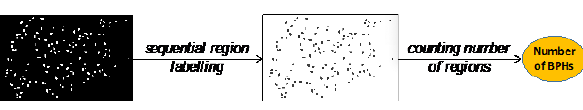
Figure 8. Counting BPHs based on sequential region